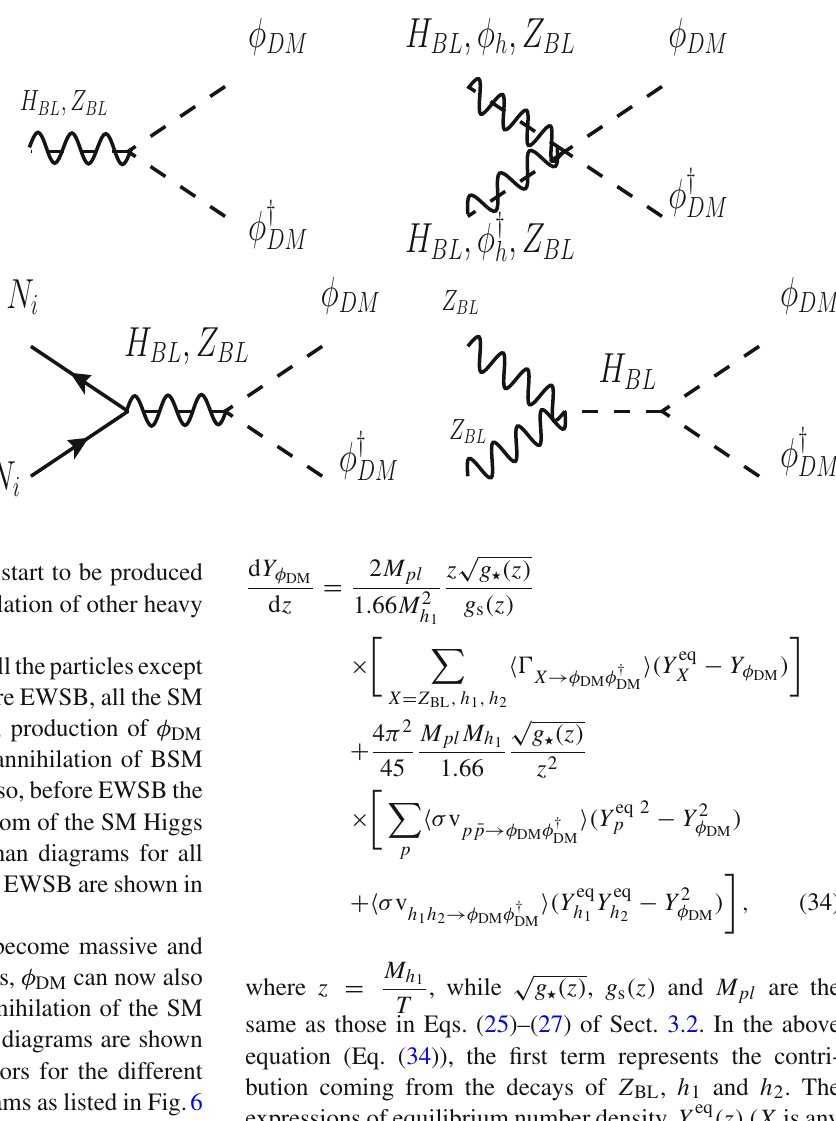
Fig. 6 Feynman diagrams